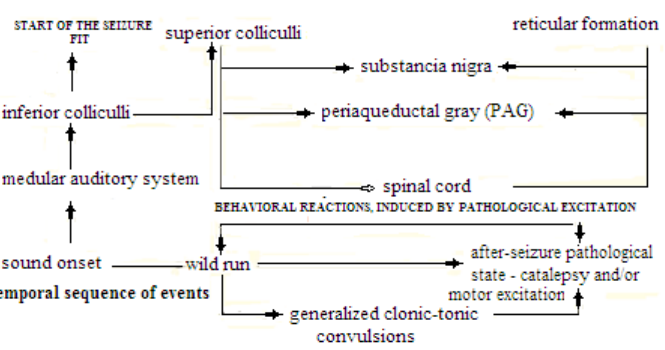
Figure 1. The schematic representation of both-brain structures, involved in the audiogenic seizure progress and the respective animal reactions, which unfold in parallel with certain structure in- volvement.